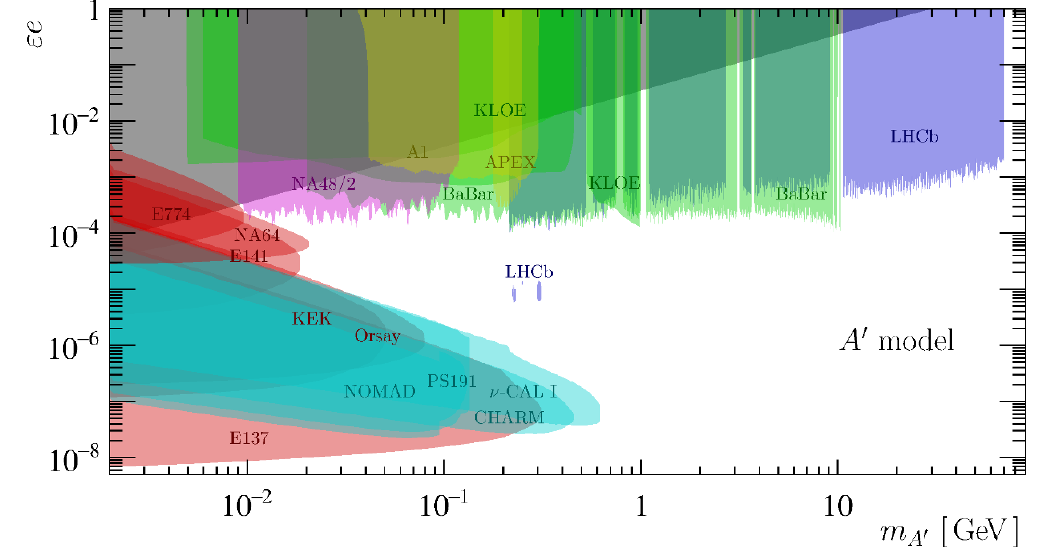
Figure 4 . Constraints on visible A 0 decays considered in this study from (red) electron beam dumps, (cyan) proton beam dumps, (green) e + e (cid:0) colliders, (blue) pp collisions, (magenta) meson decays, and (yellow) electron on (cid:12)xed target experiments. The constraint derived from ( g shown in grey [90,